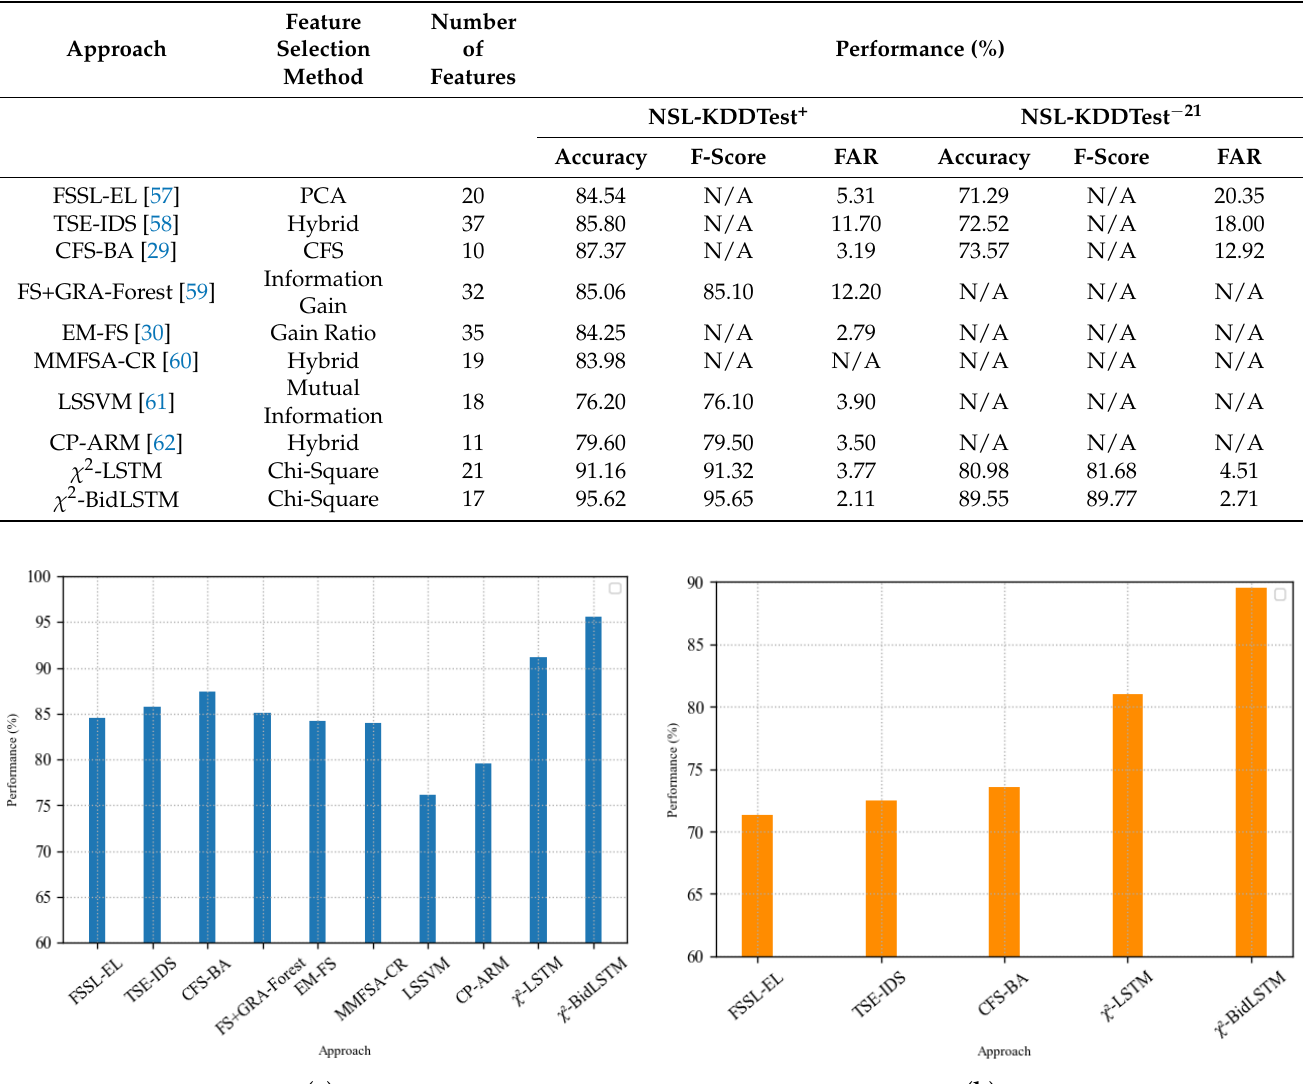
Table 19. Comparison of results against existing feature-selection-based algorithms on NSL-KDDTest + and NSL-KDDTest − 21 .